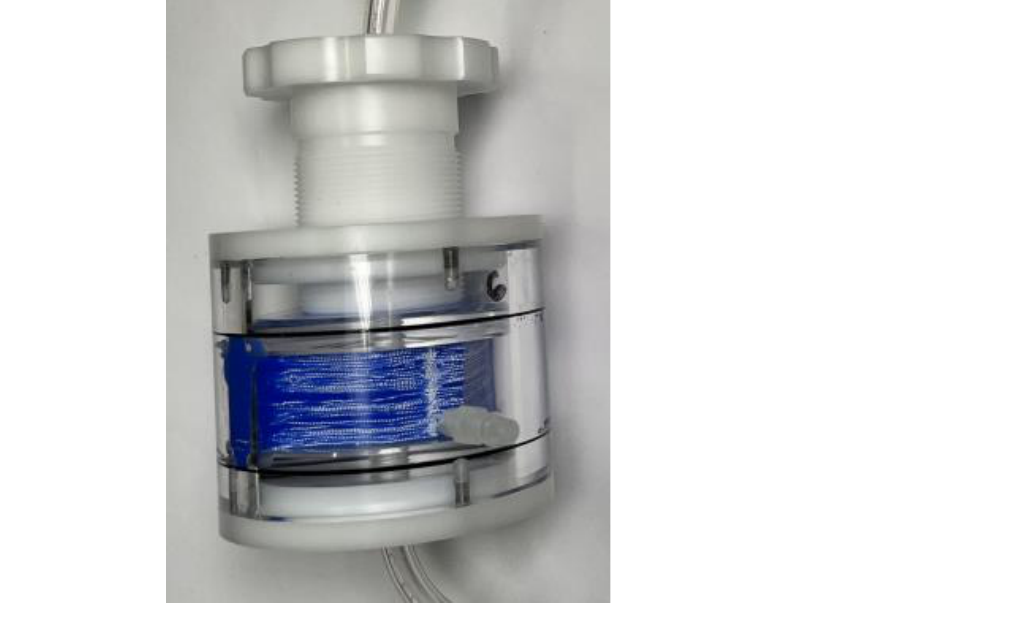
Figure 1. Fully assembled, maximum size RatOx prior to an in vitro experiment. Blue-white: Silicone potted fiber bundle (55 layers).